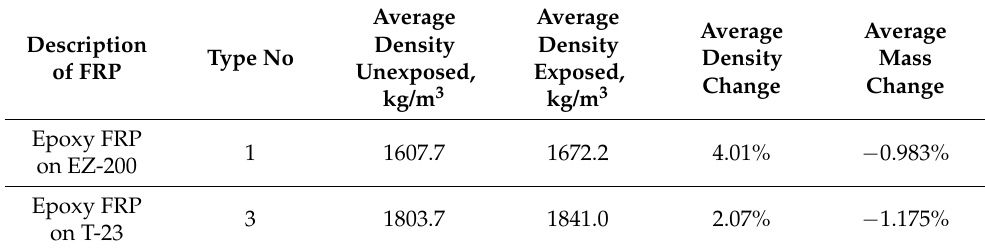
Table 2. Density changes and weight loss of tested fiberglass specimens after